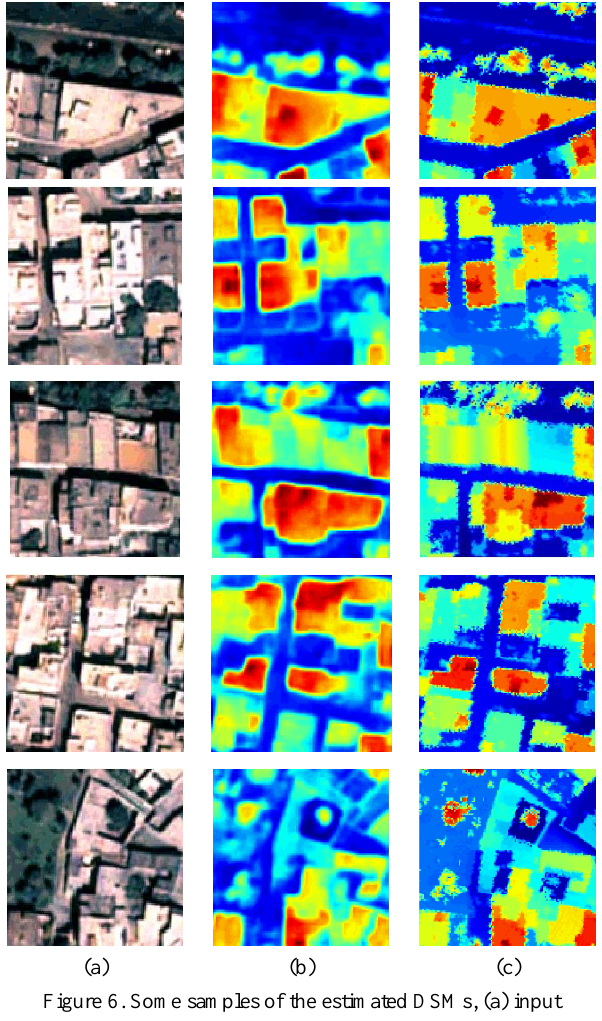
Figure 6. Some samples of the estimated DSMs, (a) input image, (b) estimated DSM, (c) reference DSM.